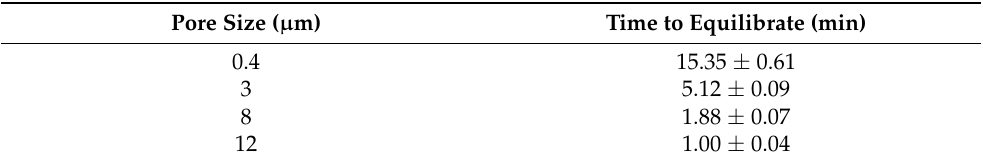
Table 1. Inserts with different pore sizes and without cells or epithelia were mounted in the Ussing system ( n = 3 inserts per pore size) and both chambers were filled to the same level with Ringer’s solution. After an additional 0.5 mL of Ringer’s solution was added to the basolateral chamber, both chambers were aerated vigorously. The time required for the two chambers to equilibrate was recorded as an indicator of fluid flow and revealed that larger pores allow for greater flow. Pore Size ( µ m) Time to Equilibrate (min) 0.4 15.35 ± 0.61 3 5.12 ± 0.09 8 1.88 ± 0.07 12 1.00 ±